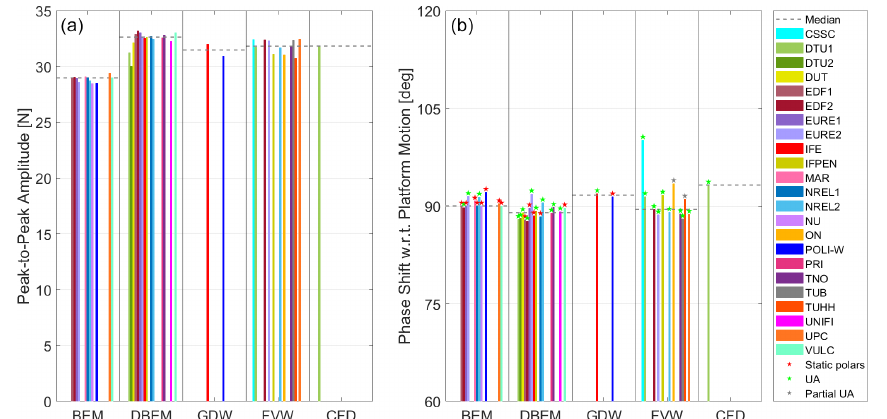
Figure 19. Aerodynamic rotor thrust peak-to-peak amplitude (a) and phase shift with regard to the platform motion (b) in Load Case 2.16.